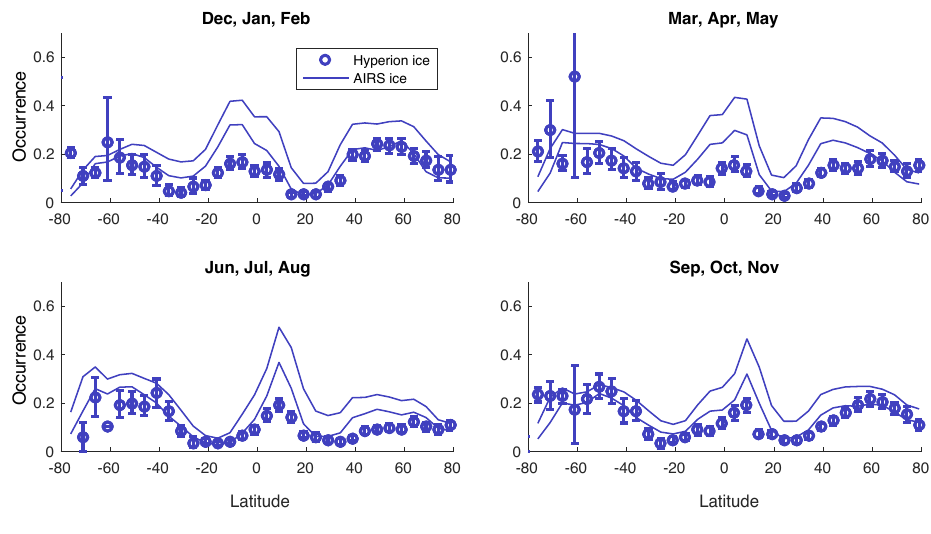
Figure A2. As in Fig. A1, for the ice